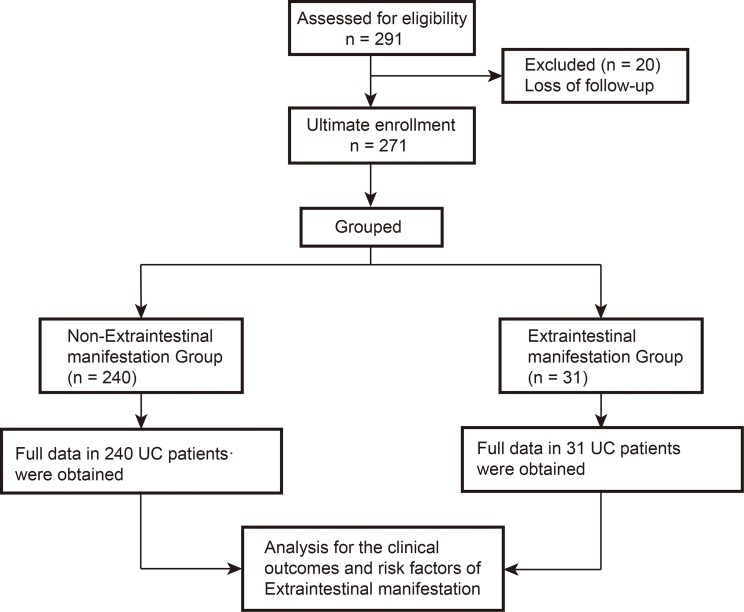
A schematic flow diagram of the present study.